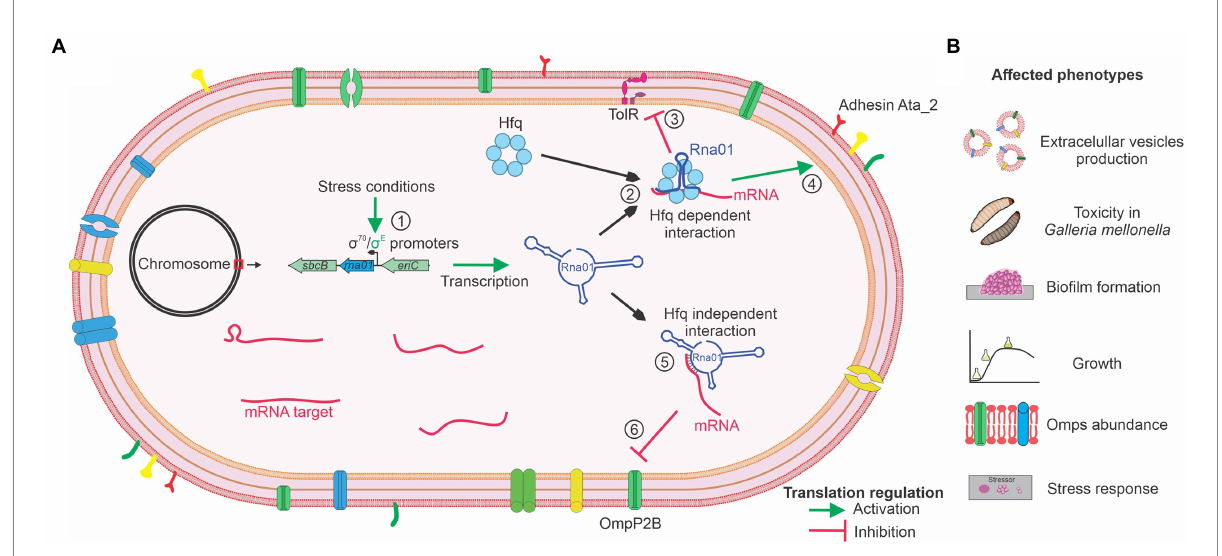
FIGURE 10 Mechanism of activity proposed for the novel sRNA Rna01. (A) The Figure summarizes the expression of rna01 in normal and stress conditions (by σ 70 and σ E , respectively) (1), followed by regulation of the targets in an Hfq dependent manner (2), inhibiting (3), or inducing (4) translation of the targets. Also, Rna01 regulates translation of the OMP targets in a Hfq-independent manner (5) by inhibiting translation (6). (B) The activity of Rna01, mediated or not by the chaperone Hfq, affects diverse phenotypes of A. pleuropneumoniae